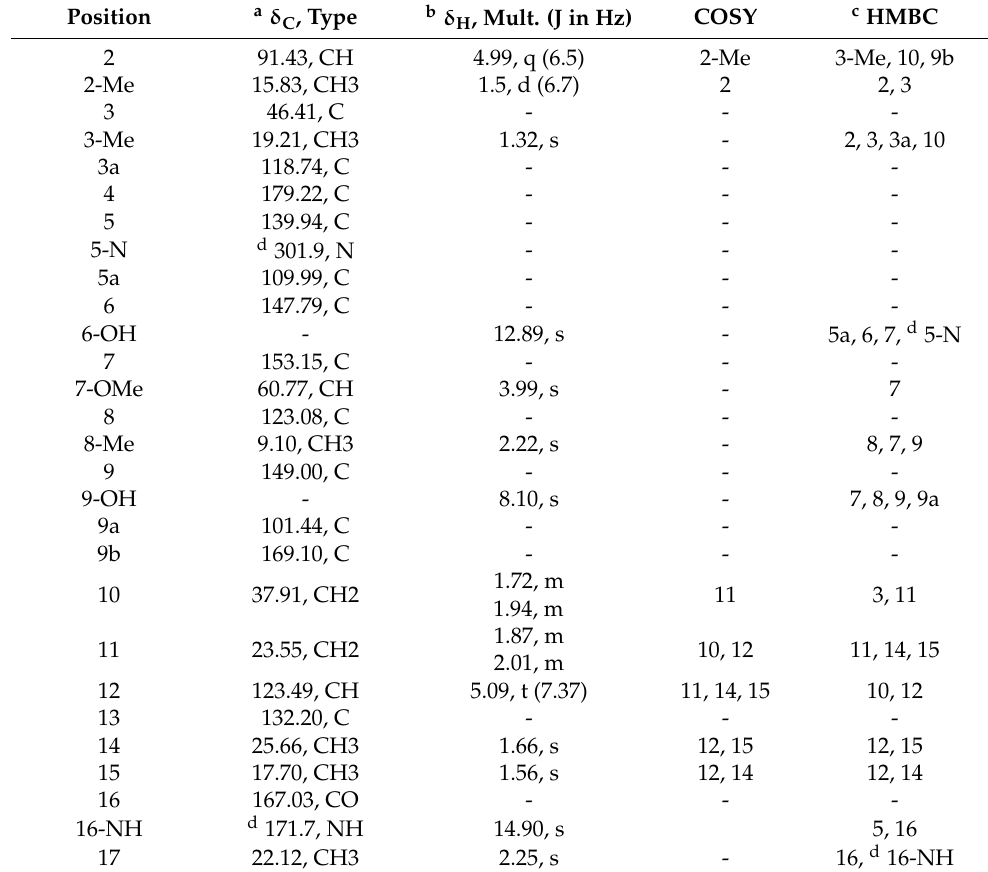
Table 2. NMR chemical shifts and 2D correlations of furaquinocin L recorded in CDCl 3 . Position a δ C ,